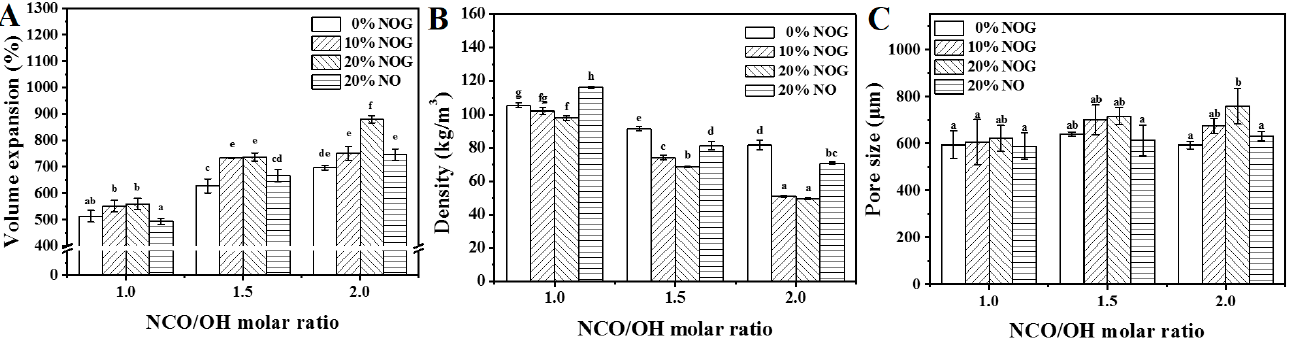
Figure 3. Volume expansion ( A ), density ( B ) and pore size ( C ) of PU foams. The NCO/OH molar ratios of O1-2, O2-2 and O3-2 set as 1.3, 1.9 and 2.5, respectively. The data analyzed using one-way ANOVA with Scheffe’s test, the different lowercase letters indicate statistical differences in the bar graph.